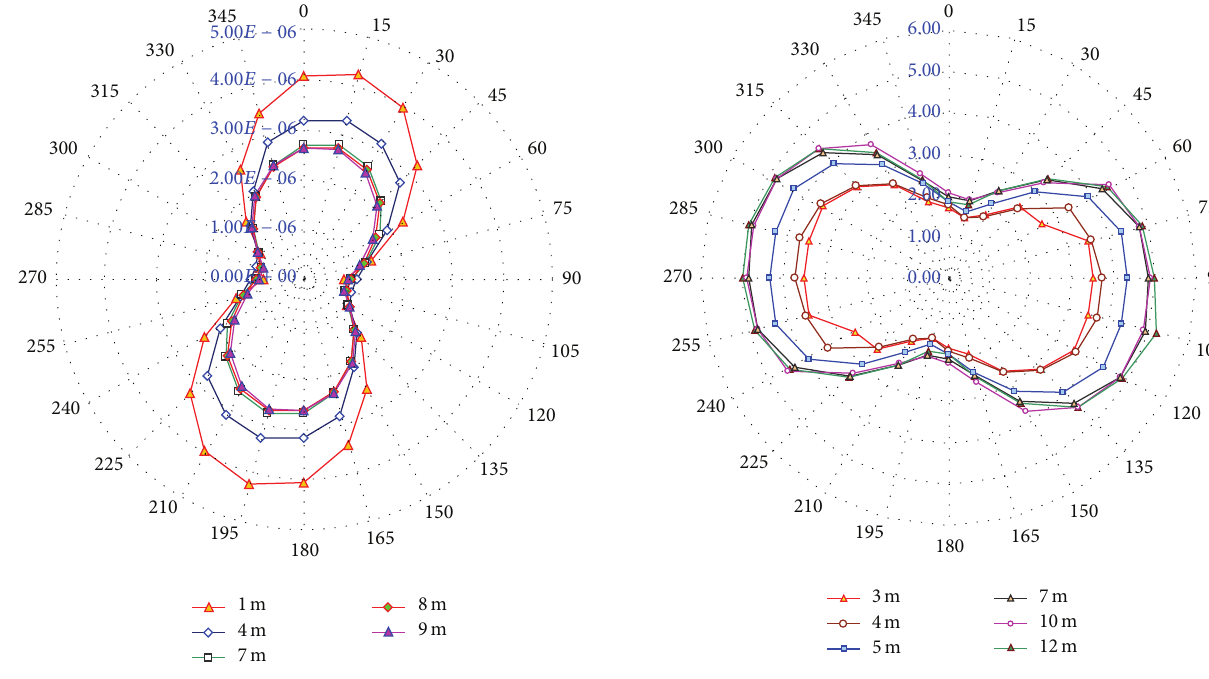
Figure 12: Permeability tensor of the rock mass (unit: m/s).